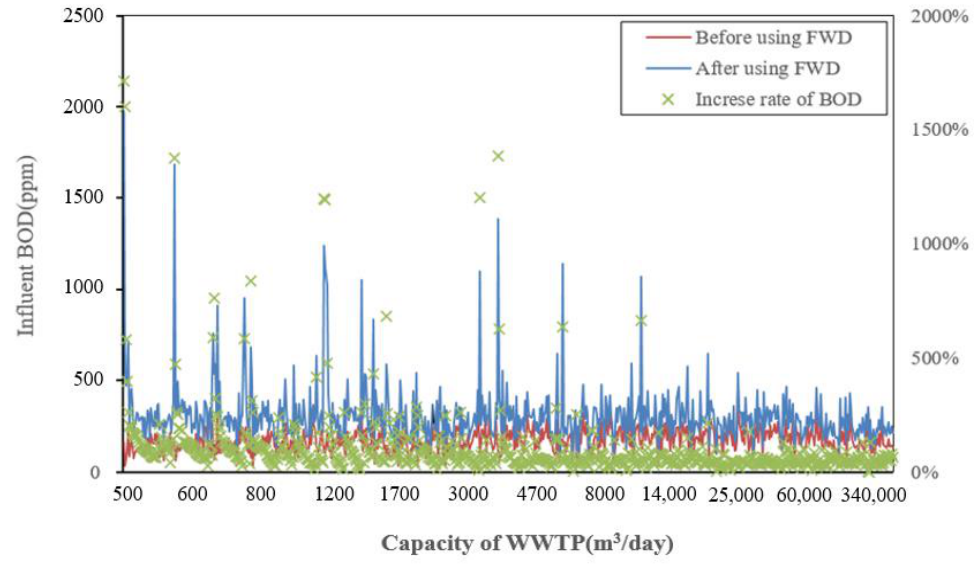
Figure 4. BOD concentration before and after the introduction of FWD by the capacity of WWTP.